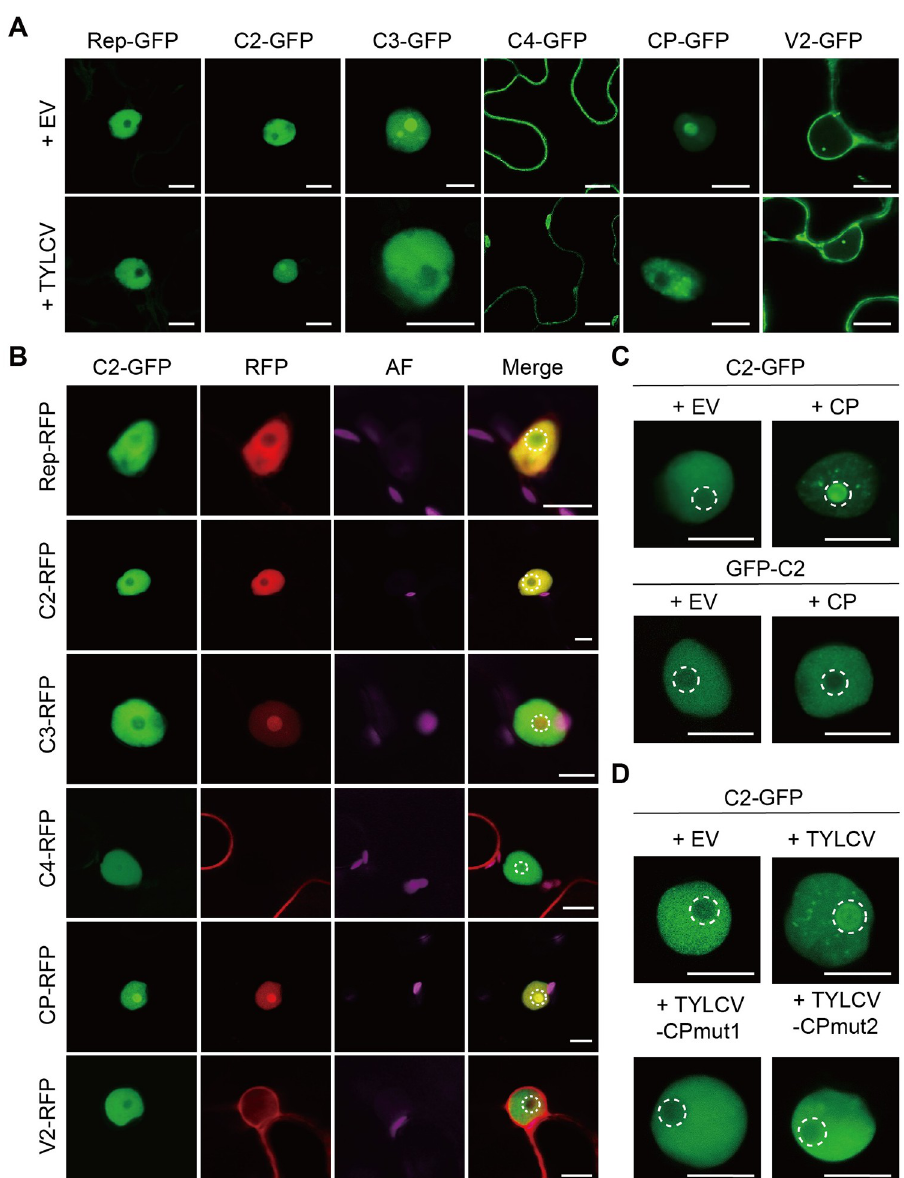
Fig 3. CP is required and sufficient to change the subnuclear localization of C2. (A) Subcellular localization of the TYLCV-encoded proteins fused to GFP at their C-terminus expressed alone (+EV; co-transformed with an empty vector control) or in the context of the viral infection (+TYLCV; co-transformed with a TYLCV infectious clone) in N . benthamiana leaves at 2 days post infiltration (dpi). Scale bar = 10 μ m. EV: empty vector. (B) Subcellular localization of C2-GFP co-expressed with each of the viral proteins fused to RFP in N . benthamiana leaves at 2 dpi. Scale bar = 10 μ m. AF: Autofluorescence. (C) Subcellular localization of C2-GFP or GFP-C2 when expressed alone (+EV) or co-expressed with CP (+CP) in N . benthamiana leaves at 2 dpi. The accumulation of the CP transcript is shown in S6A Fig. Scale bar = 10 μ m. EV: empty vector. (D) Subcellular localization of C2-GFP when expressed alone (+EV) or in the context of the infection by the WT TYLCV virus (+TYLCV) or mutated versions unable to produce CP (+TYLCV-CPmut1; +TYLCV-CPmut2) in N . benthamiana leaves at 2 dpi. Scale bar = 10 μ m. EV: empty vector. Viral accumulation is shown in S6B Fig. For details on TYLCV-CPmut1 and TYLCV-CPmut2, see Materials and Methods. In ( B - D ), the dashed circles mark the nucleolus. See also S6 Fig.